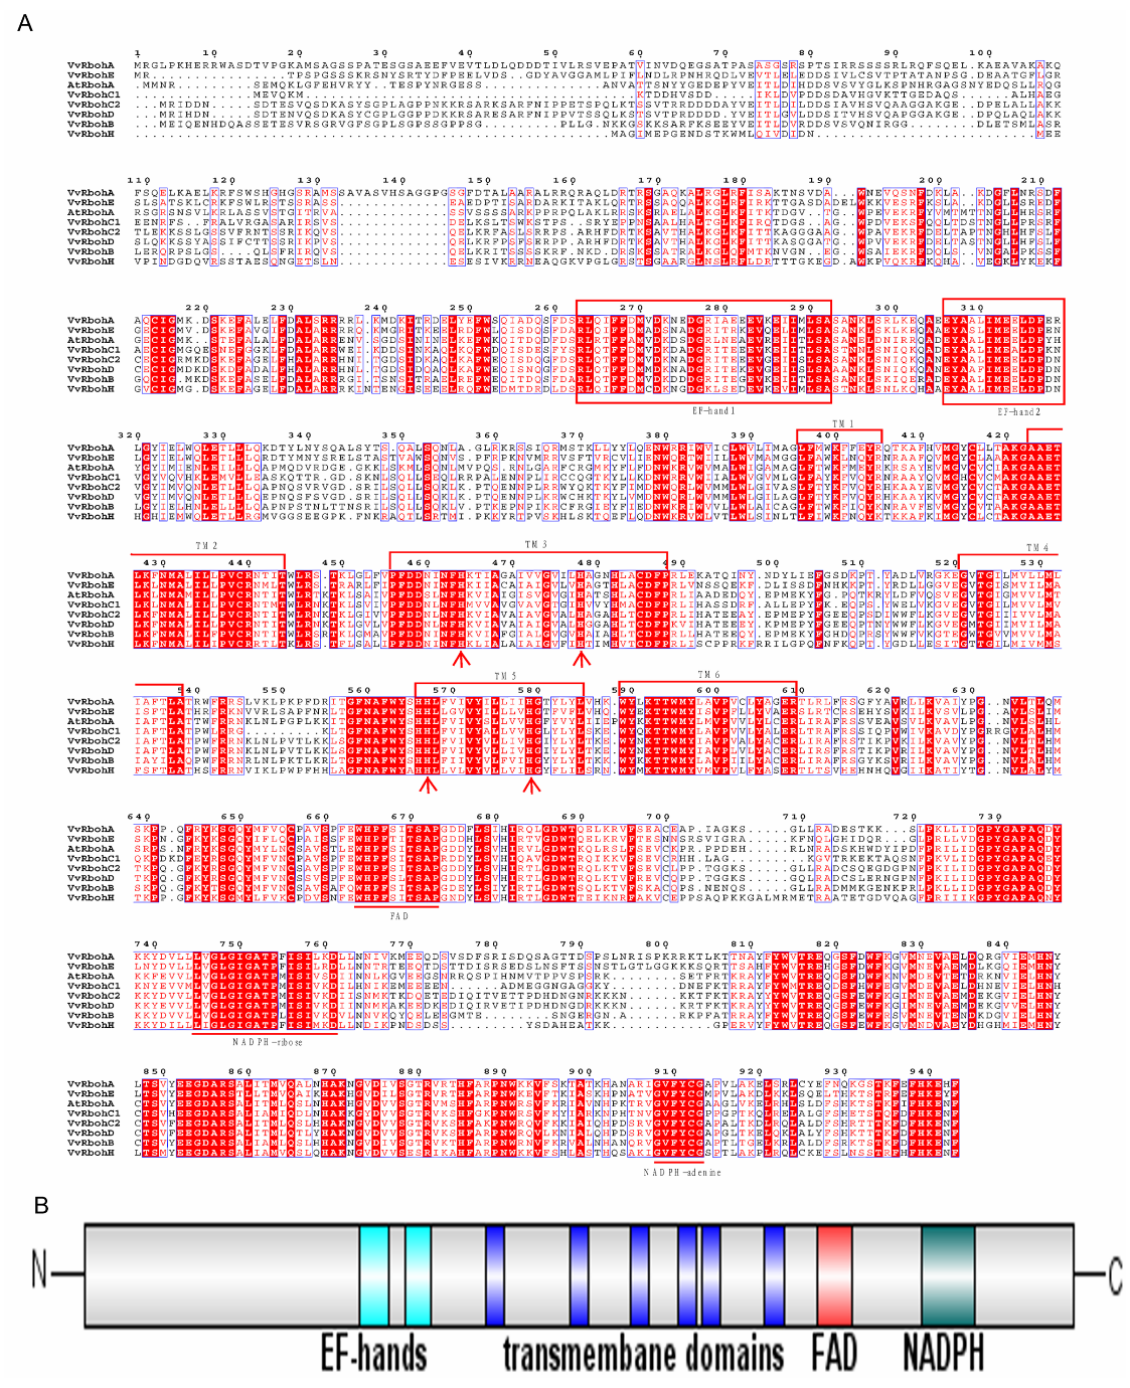
Figure 1. Protein alignment and domain structure of AtRbohA and the seven predicted grape respiratory burst oxidase homolog (Rboh) proteins. ( A ) The red shading indicates residues that are identical and the lighter shading represents positions with a lower level of conservation. EF-hand domains are indicated by the boxes. Conserved binding sites for flavin adenine dinucleotide (FAD), NADPH-ribose and NADPH-adenine are indicated with a straight line below the alignment. Histidine residues involved in heme binding are indicated by arrows. Putative transmembrane domains (TMs) are indicated by brackets above the alignment; and ( B ) Schematic representation of the grape Rboh proteins with their respective functional domains, showing that grape Rboh proteins are similar to Arabidopsis